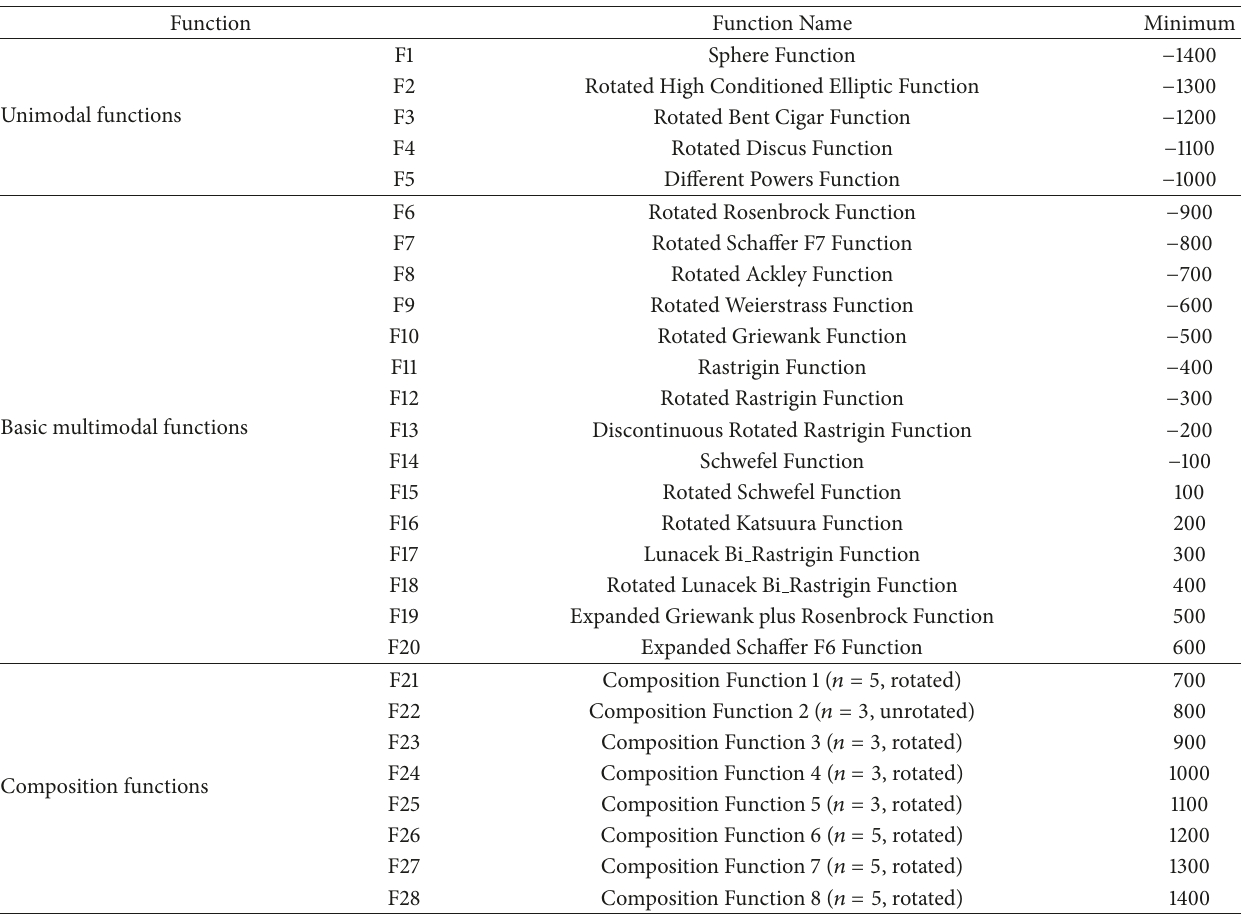
Table 1: 2013 CEC benchmark functions, where the search range of all functions is −100 ≤ 𝑠 𝑖 ≤ 100 . More details about these functions can be found in